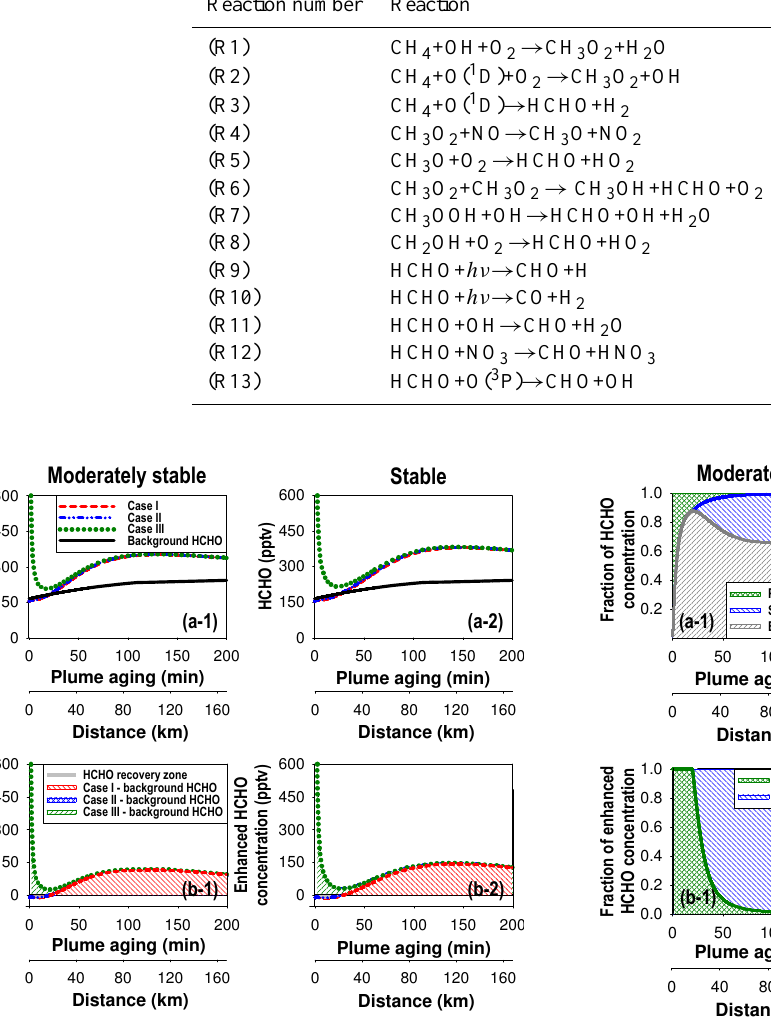
Fig. 4. HCHO budget by sources for the ITCT 2K2 ship-plume case: (a) source fraction of the ship-plume HCHO mixing ratios and (b) source fractions of the enhanced ship-plume HCHO mix- ing ratios. The first and second columns show the results from the model-simulations under the moderately stable (E) and stable (F) MBL conditions, respectively. Instead, the enhanced rate of the atmospheric oxidation of CH 4 (e.g., check the differences between red-dashed lines and black-solid lines in the first row of Fig. 3) is the most likely cause for the enhanced HCHO levels. The